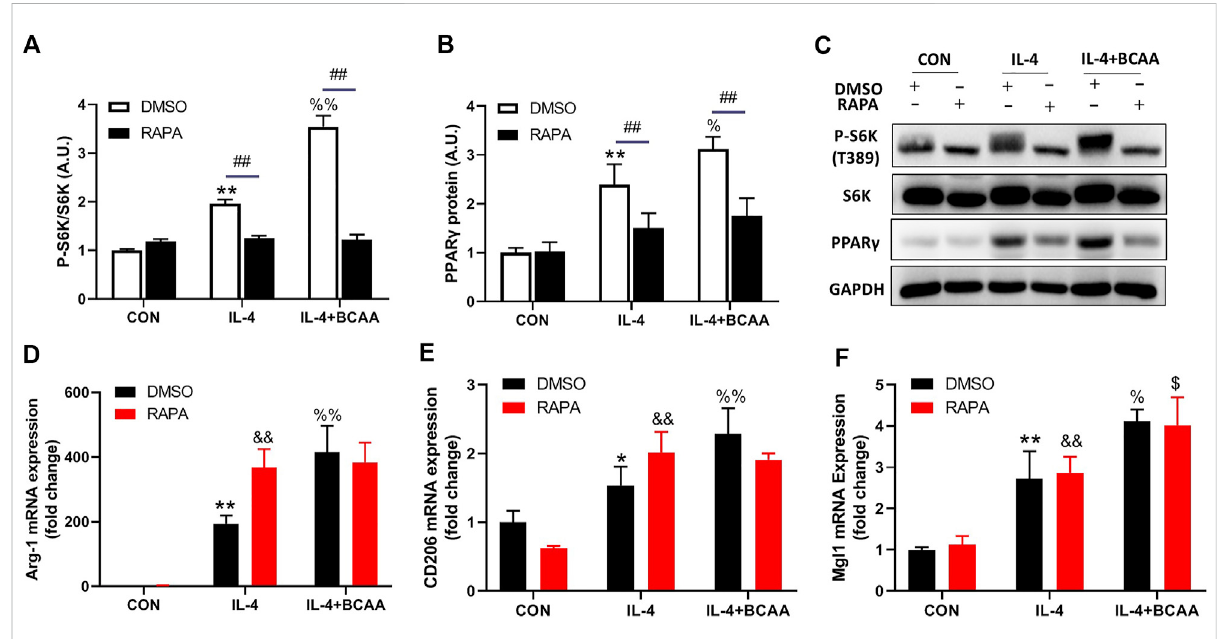
FIGURE 6 BCAAs promote M2 polarization independent of the mTORC1-PPAR γ pathway. (A – C) BCAAs (800 μ m) enhanced the expression of PPAR γ and mTORC1activityduringM2polarization,andtheeffectofRAPA(rapamycin,mTORC1inhibitor)ontheexpressionofPPAR γ . (D – F) TheeffectofRAPA onthechangeinM2polarization.Dataareexpressedasmean±SEM.* p < 0.05,** p < 0.01vs.CON/DMSOCON; & p < 0.05, && p < 0.01vs.RAPACON; % p < 0.05, %% p < 0.01 vs. IL-4/DMSO IL-4; $ p < 0.05, $$ p < 0.01 vs. RAPA IL-4; # p < 0.05, ## p < 0.01 between groups IL-4 or